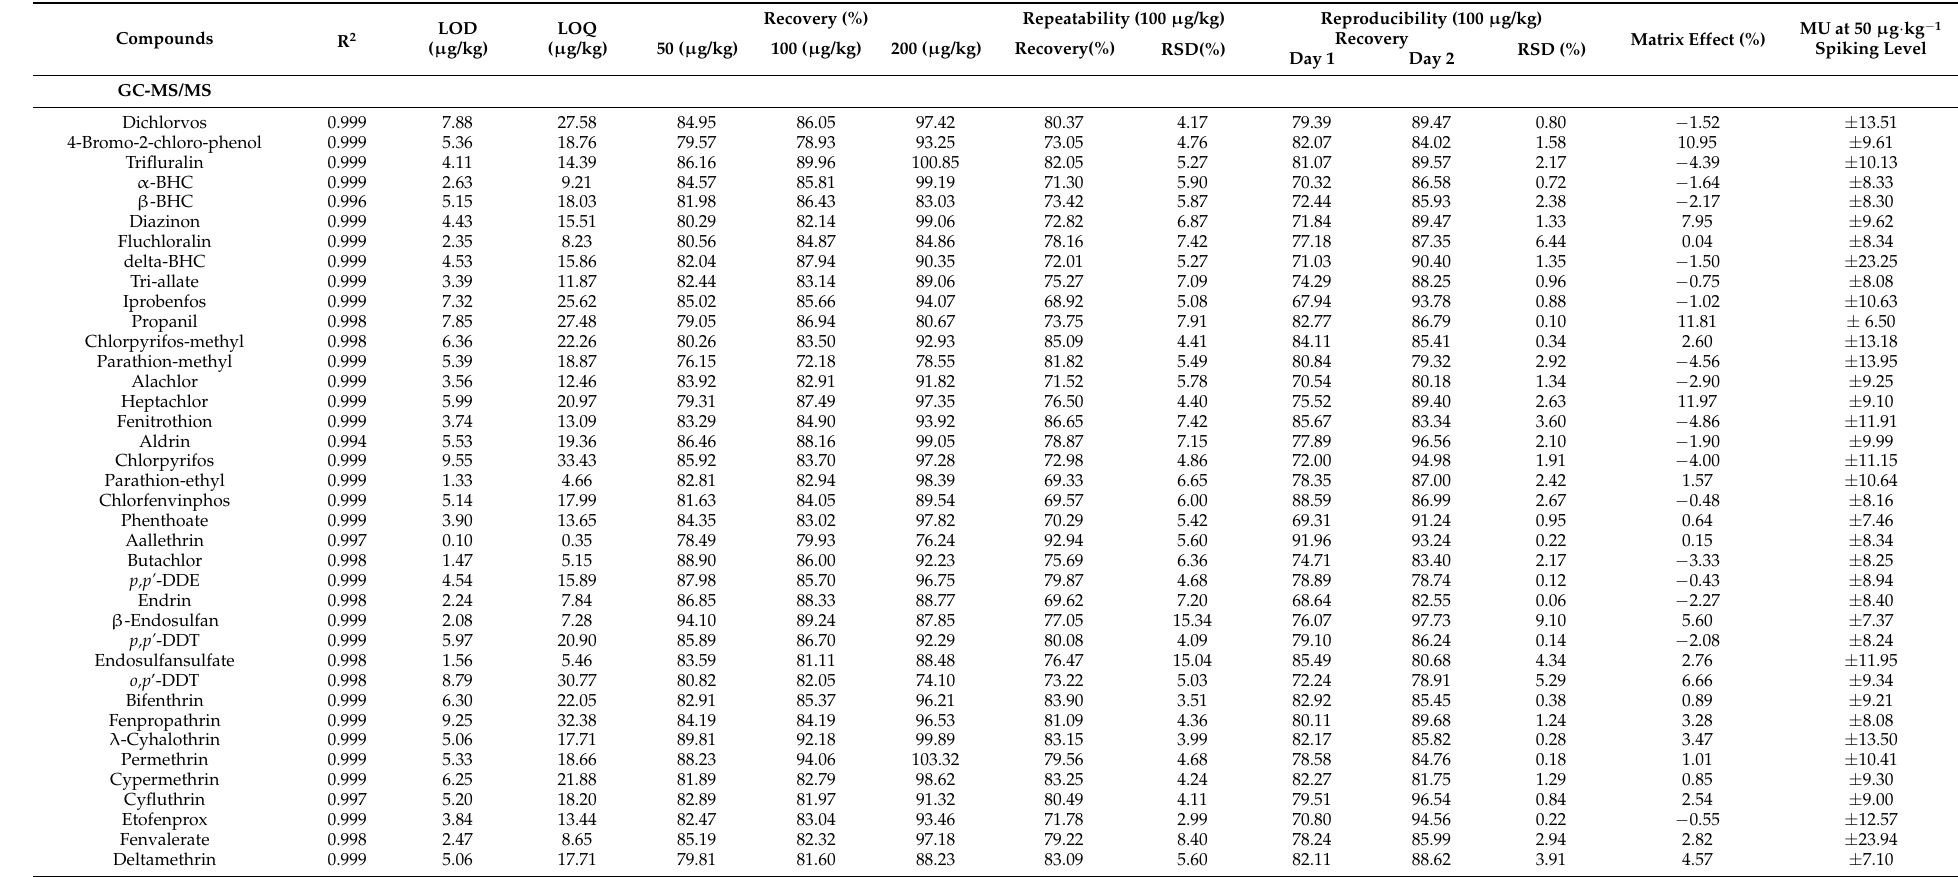
Table 3. Coefficient of determination ( R 2 ), LOD, LOQ, recovery and repeatability of multiclass pesticide analyzed in tomato fruits using GC-MS/MS and LC-MS/MS.